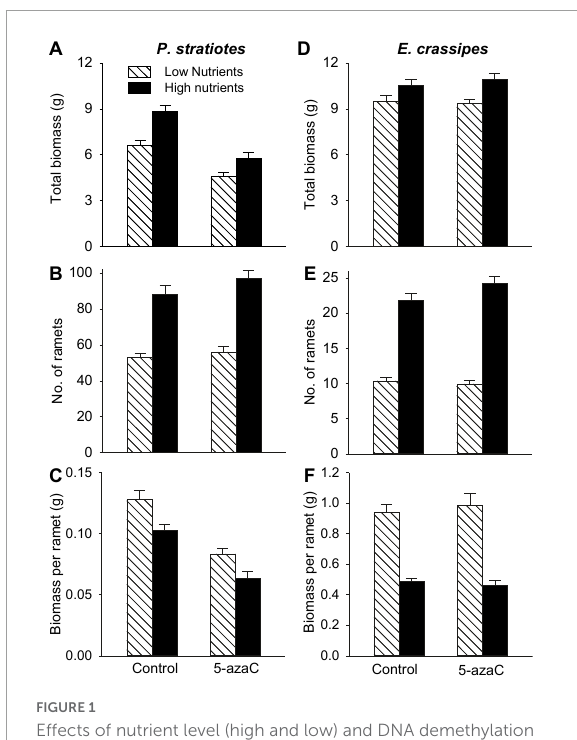
FIGURE1 Effects of nutrient level (high and low) and DNA demethylation (control and 5-azaC) on the growth of offspring ramets of (A–C) Pistia stratiotes and (D–F) Eichhornia crassipes . Bars show means + SE.